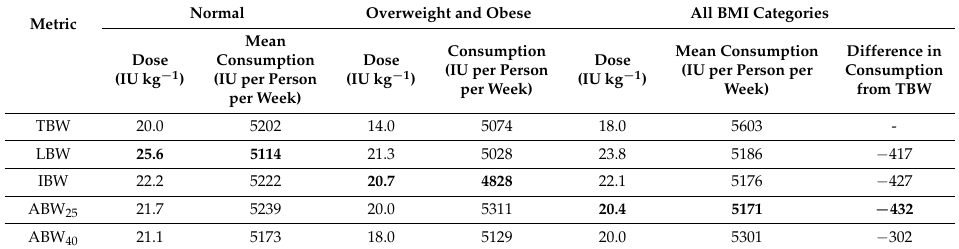
Table 3. Summary of safety and economic evaluations of different weight metrics used in a Q48 h